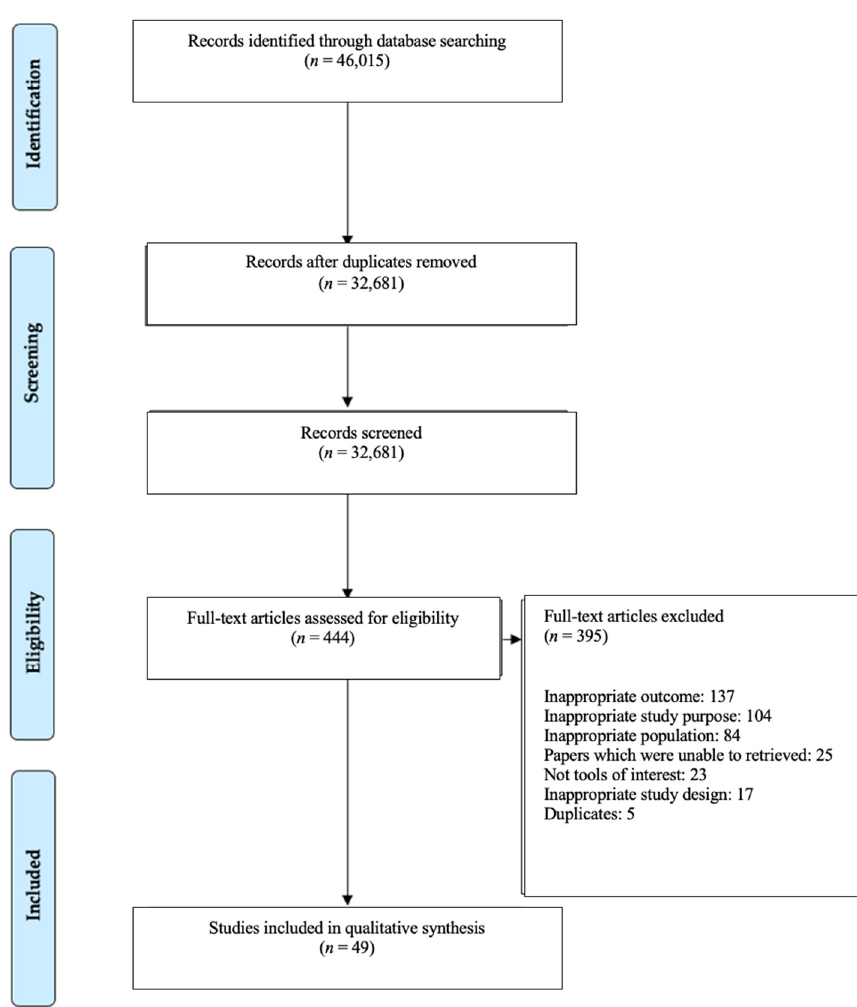
Figure 1. PRISMA flow chart for study selection process.